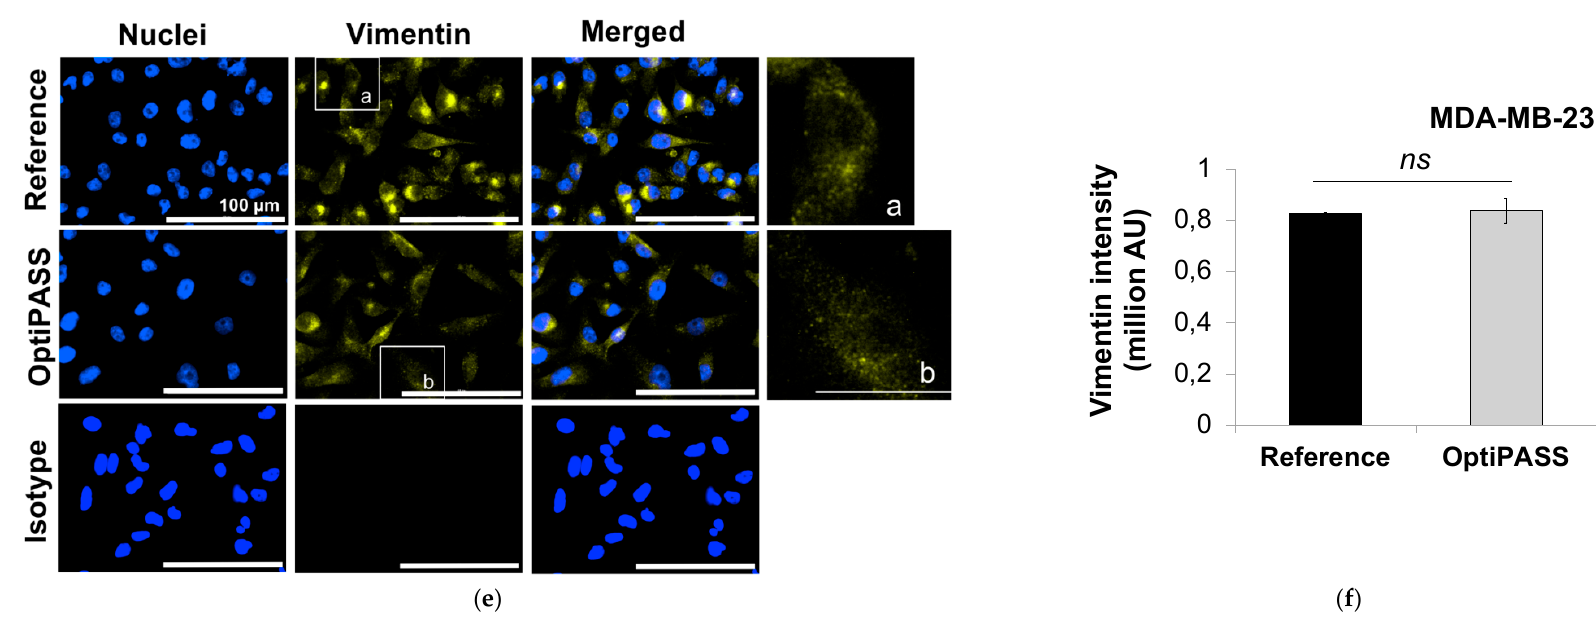
Figure 1. MDA-MB-231 monolayer cell culture development with OptiPASS medium. ( a ) 2D proliferation rates: the number of adherent cells was counted with Cytation3MV plate reader (BIOTEK) after one, two, three, four and seven days of culture and normalized to cell counting at day one, n = 9, bars = s.e.m. ( b ) Cell metabolic activity monitoring: the metabolic activity of adherent cells was quantified with resazurin test for seven days and normalized to cell metabolic activity quantified at day one, n = 16, bars = s.d. ( c ) Cell repartition profile: cells cultured in reference medium or OptiPASS medium were harvested and counted with a blue trypan exclusion test. Three cell categories are represented: “floating” and “dead” cells were counted in the supernatant medium, and “adherent” cells were counted after trypsinization of the cellular carpet. n = 5, ns = non-significant difference with student t-test ( d ) Cellular carpet morphology in phase contrast imaging: each well of the six-well microplate was imaged at day one, two, three, four and seven (confluence) with Cytation3MV plate reader. Images (M = 4X) were stitched to allow an overview of the all well. Well area = 9.6 cm 2 . ( e )Vimentin immunofluorescent staining: cells cultured in reference or OptiPASS medium were immunoassayed for vimentin expression and imaged with Cytation3MV (GFP and Cy5 filters). The isotype control is the negative control for vimentin expression. Scale bar = 100 µ m, blue = nuclei, yellow = vimentin. ( f ) Vimentin intensity quantification per cell (AU, error bars = s.d.). ns = non-significantly different, *** = p < 0.001, two-sided student’s t -test comparison.